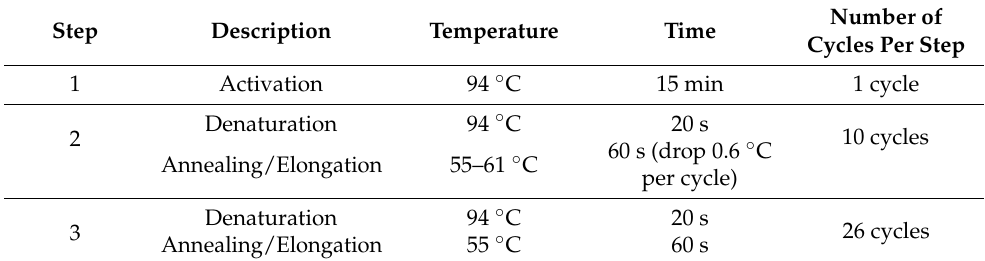
Table 4. Thermal cycle conditions for KASP genotyping